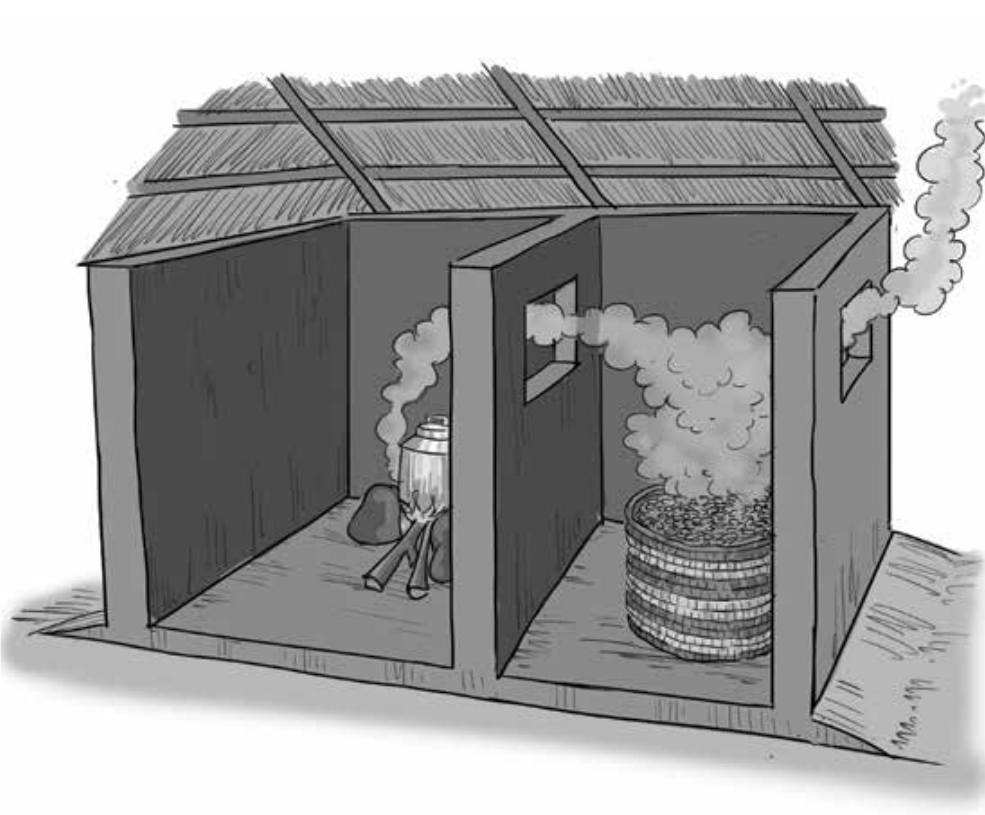
Figure 9: Smoke from the cooking fire in the kitchen is used to fumigate the crop in the improved granary, which is built adjacent to the kitchen